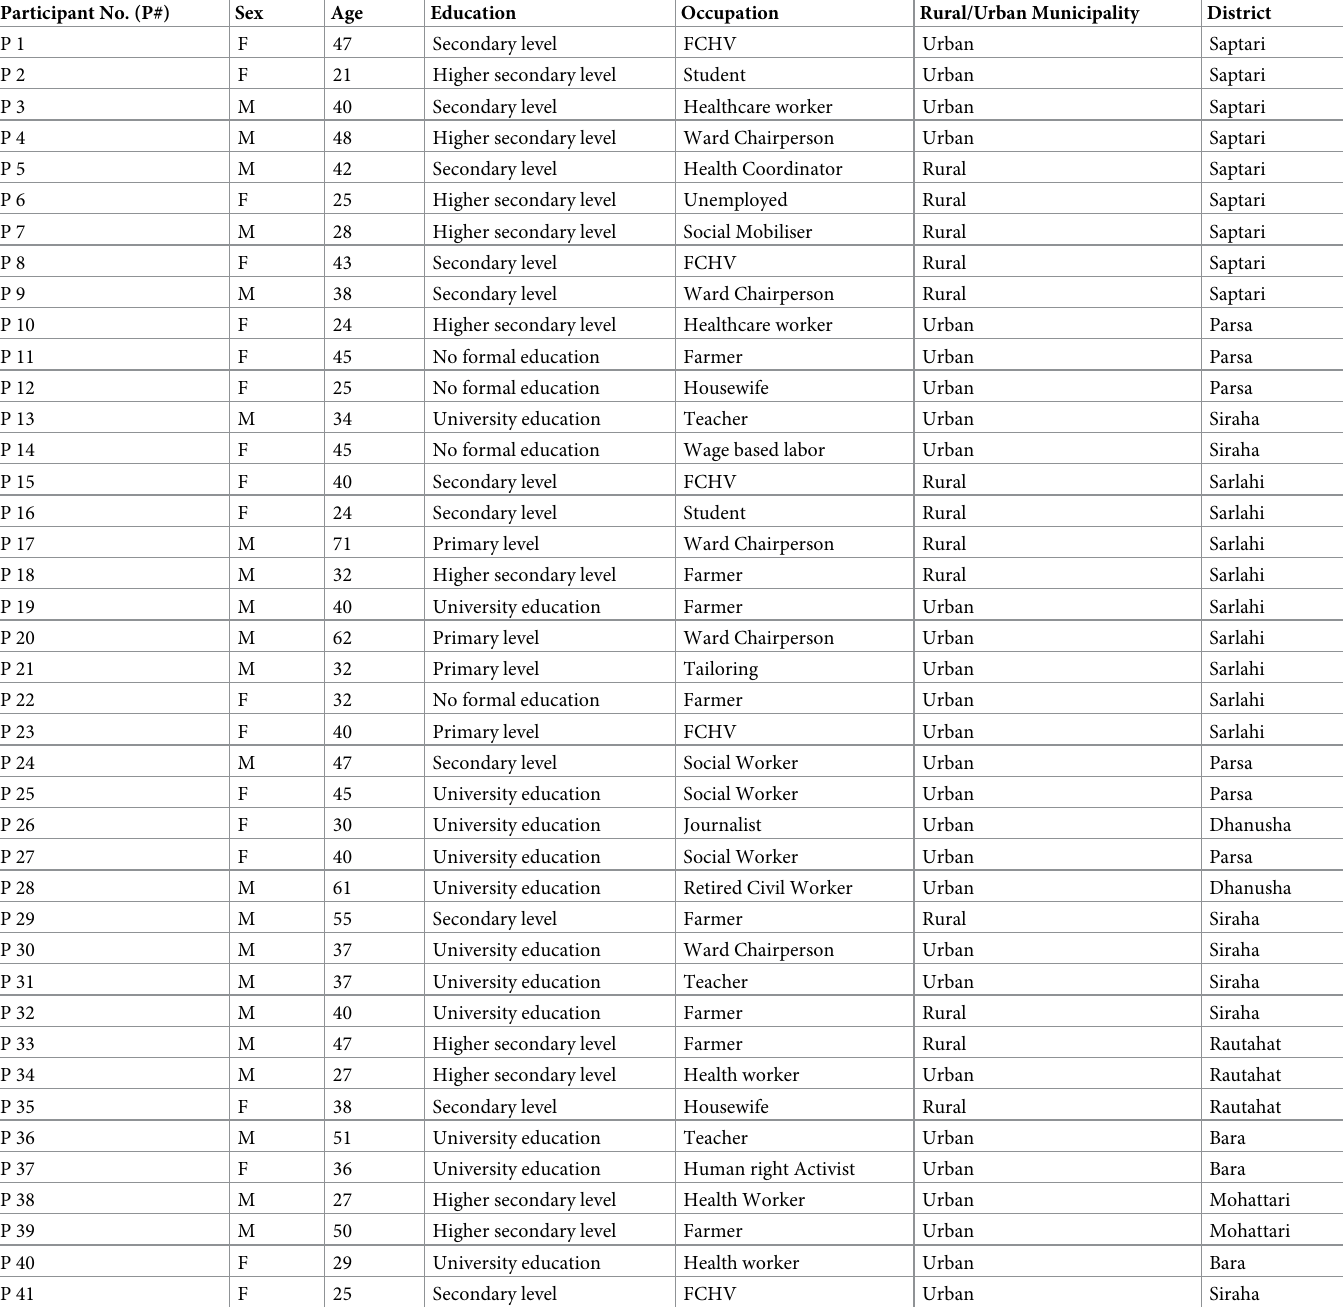
Table 1. Characteristics of study